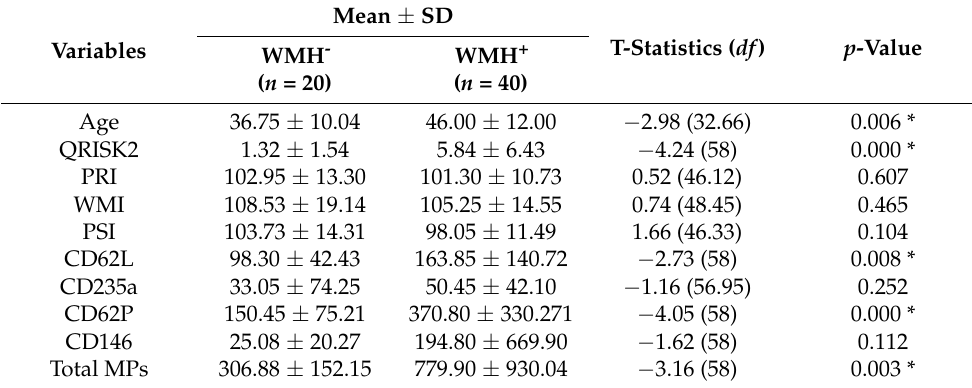
Table 2. Independent T -tests for comparison of the study variables between WMH + and WMH -